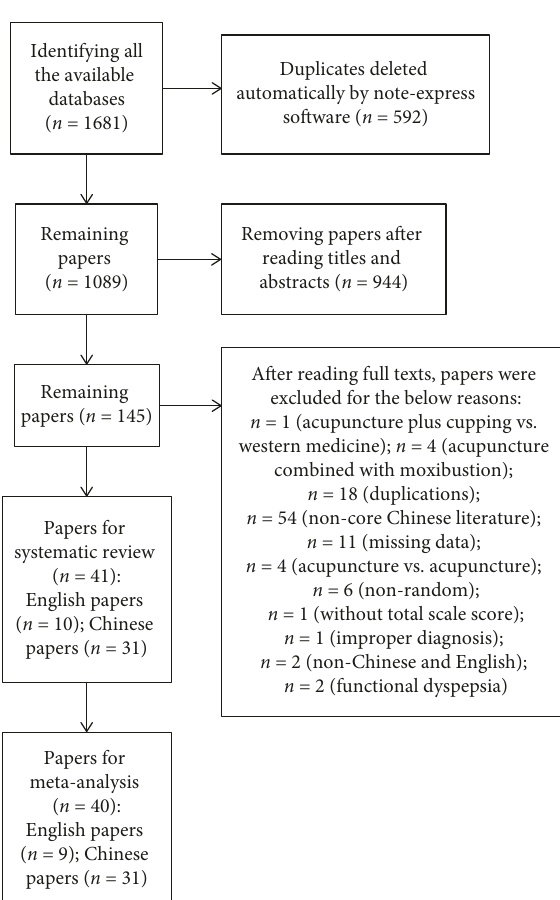
Figure 1: Screening flow